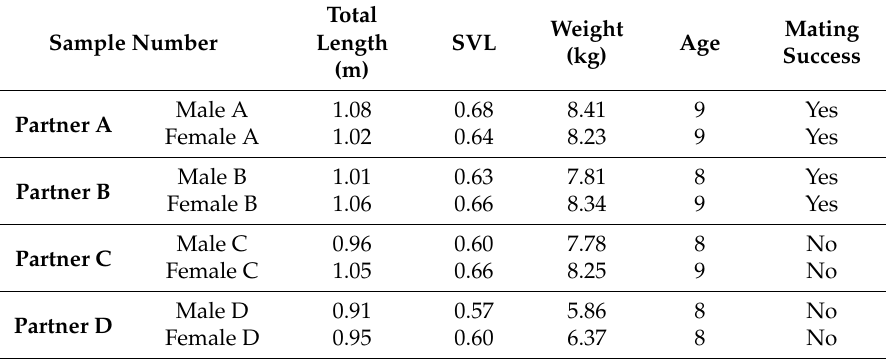
Table A1. Description of characteristics of Andrias davidianus used in